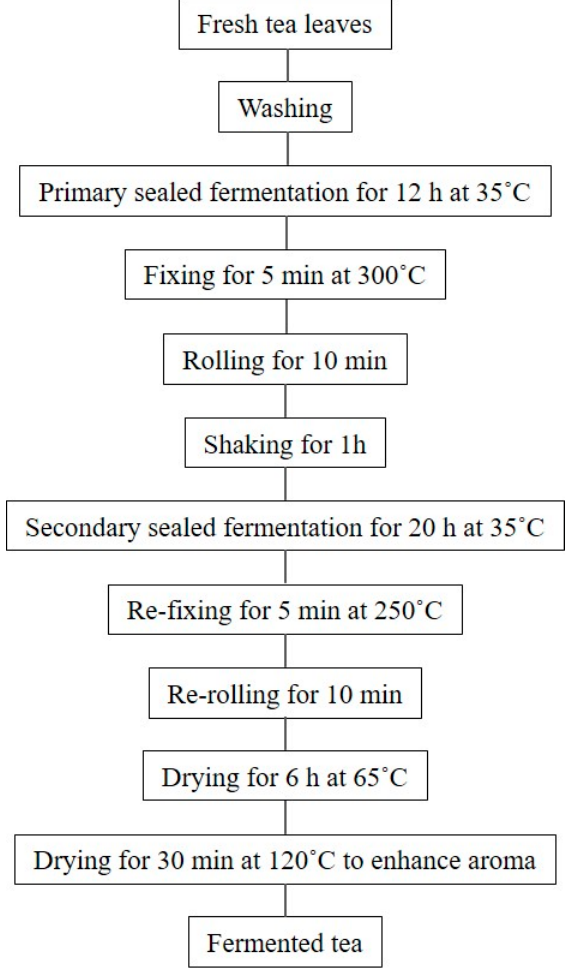
Figure 4. Flowchart of NFT preparation from fresh tea leaves.